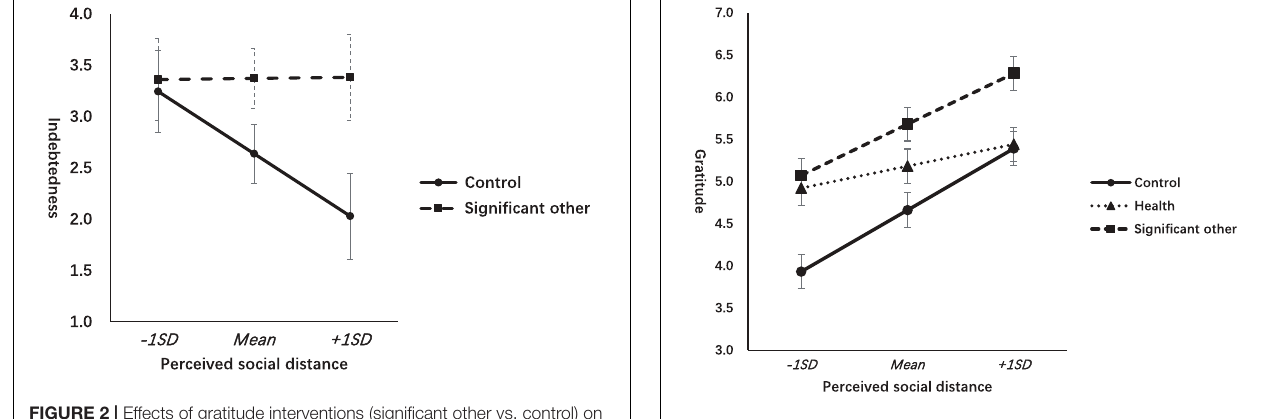
FIGURE 3 | Effects of gratitude interventions on gratitude across levels of perceived social